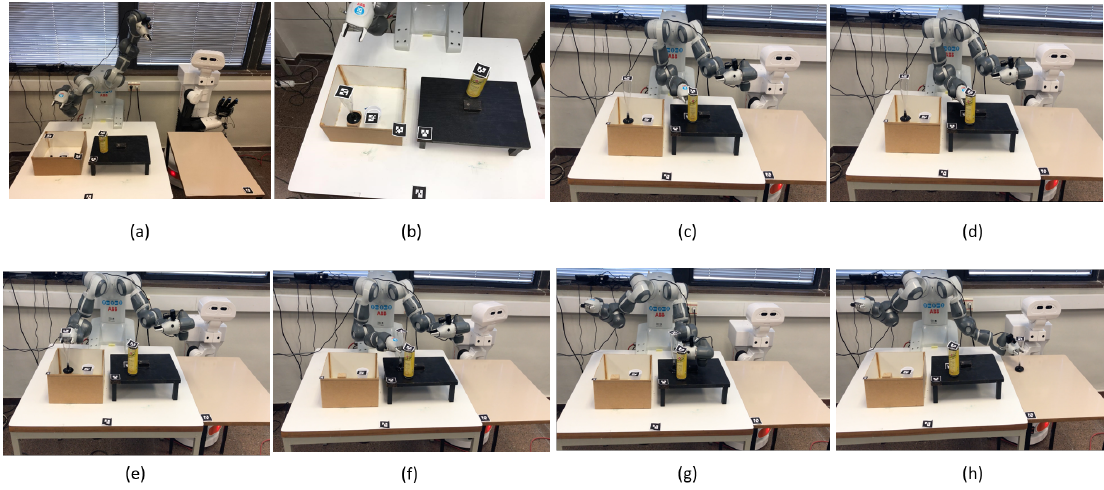
Figure 12. The sequence of snapshots for the execution of the serve a glass of wine instruction. Video URL-link